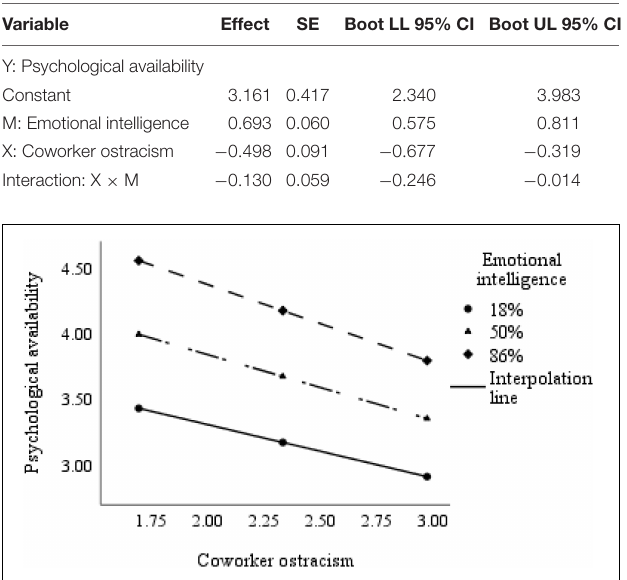
FIGURE 2 | Interactive effect of coworker ostracism and emotional intelligence on newcomers’ psychological availability.